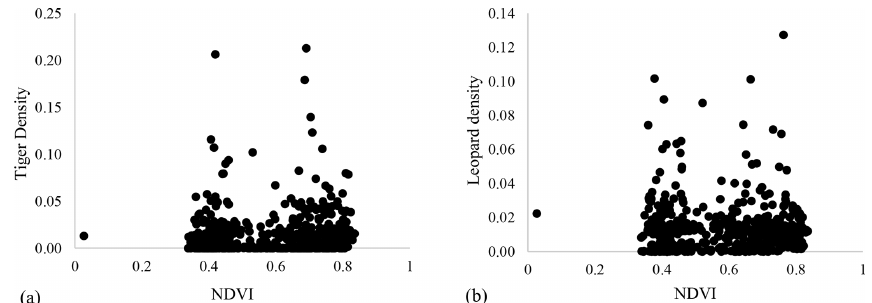
Figure B2. Relationship between vegetation cover (NDVI) and (a) tiger density and (b) leopard density in Pench Tiger Reserve, Madhya